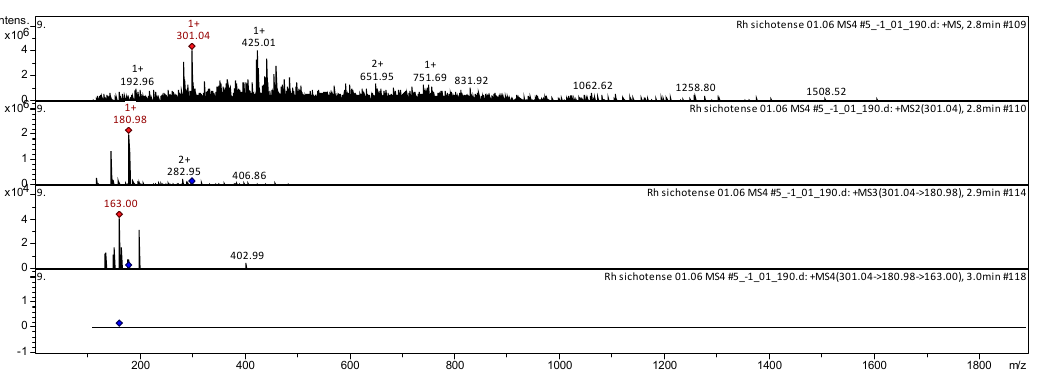
Figure 11. CID spectrum of farrerol from Rh. adamsii , m/z 301.06.